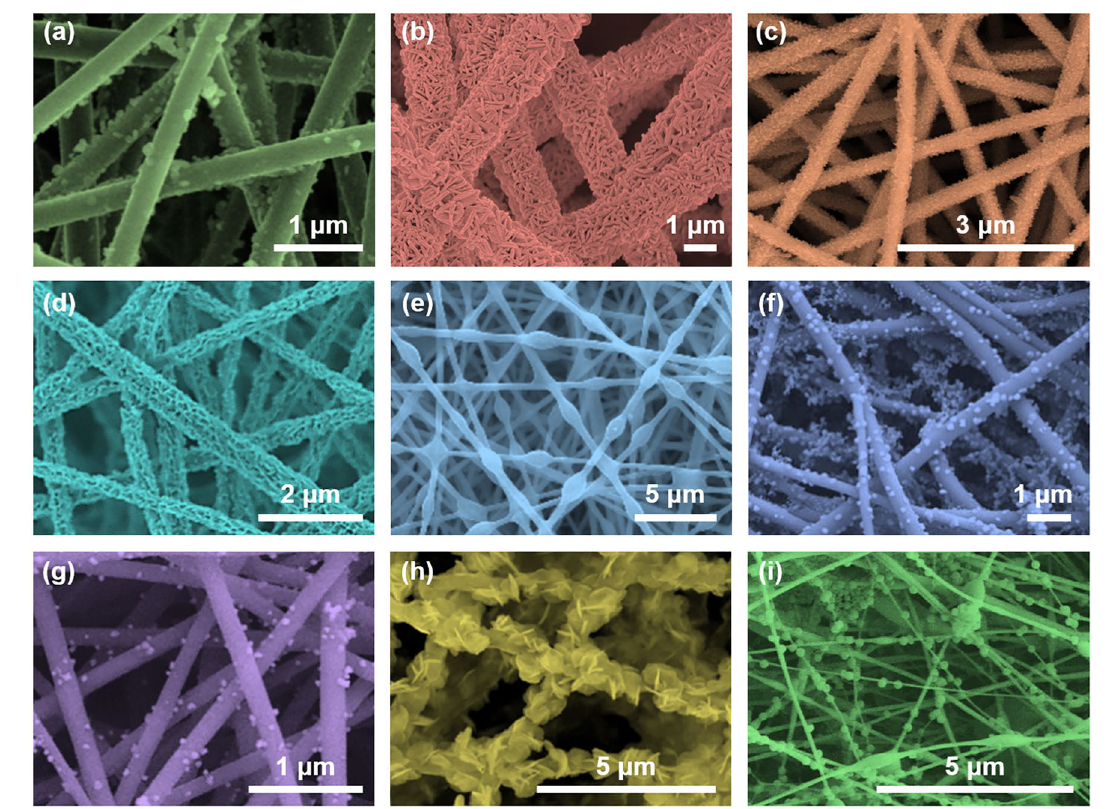
Fig. 6 SEM images of hierarchical SNFs: a Nickel ferrite nanoparticles anchored onto SNFs [114]. Copyright 2015, American Chemical Soci‑ ety. b Boehmite nanoplatelets are anchored on the surface of SNFs [115]. Copyright 2012, American Chemical Society. c Polyaniline (PANI) coated on SNFs [116]. Copyright 2017, Elsevier. d CuO‑ZnO nanosheets deposited on SNFs [117]. Copyright 2022, Springer Nature. e PA66 coated on SNFs [118]. Copyright 2021, IOP Publishing Ltd. f CuO nanocrystals decorated SNFs [119]. Copyright 2015, Springer Nature. g Ag nanoparticles modified SNFs [120]. Copyright 2021, Elsevier. h g‑C 3 N 4 /BiOI loaded on SNFs [121]. Copyright 2018, Elsevier. i ZIF‑8 nanocrystals anchored on SNFs [122]. Copyright 2019,